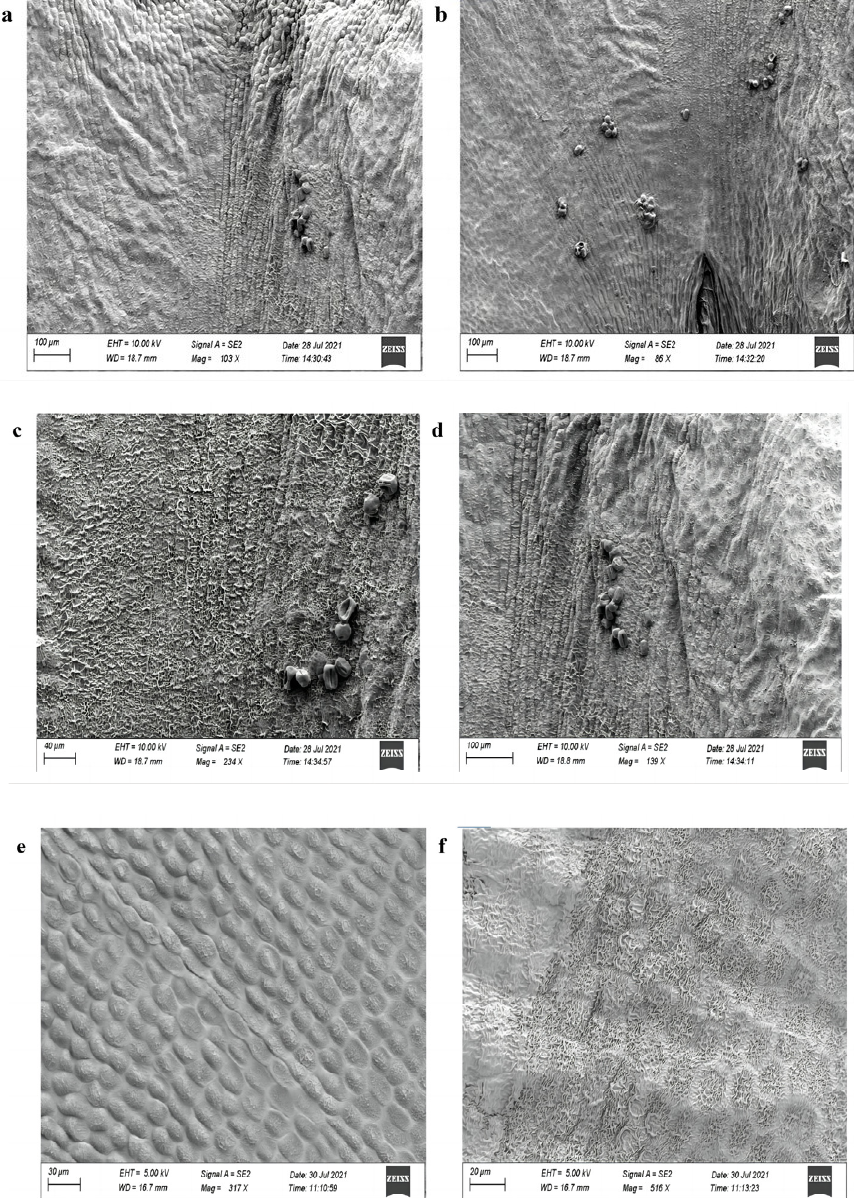
Figure 10. Comparison of scanning electron microscope results of petals between transgenic plants and wild-type plants. ( a , c , e ) OE-GmAP3 soybean; ( b , d , f ) wild-type plant.